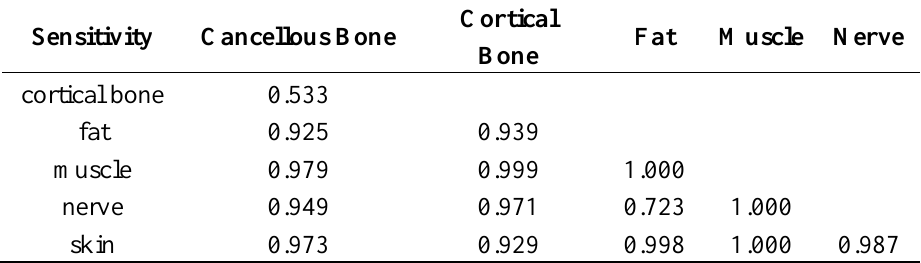
Table 3. Sensitivity of tissue differentiation.